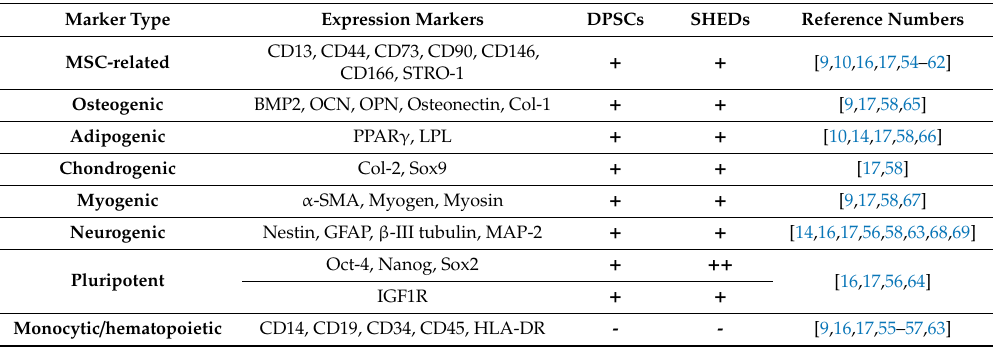
Table 1. Expression of cell markers in DPSCs and